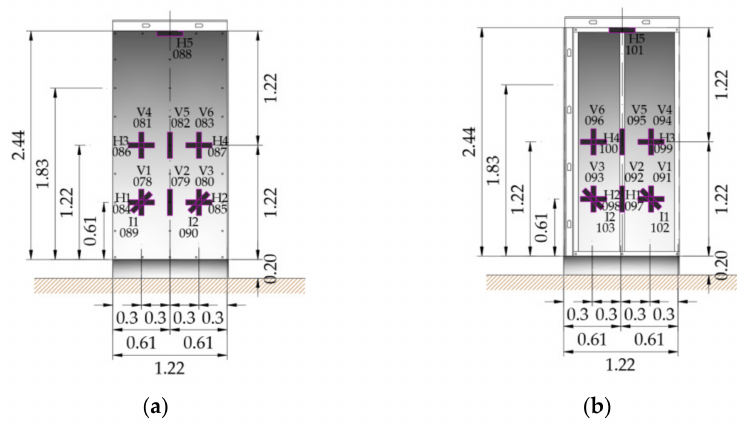
Figure 12. Strain Gauges identification on Wall 2: ( a ) North face; ( b ) South